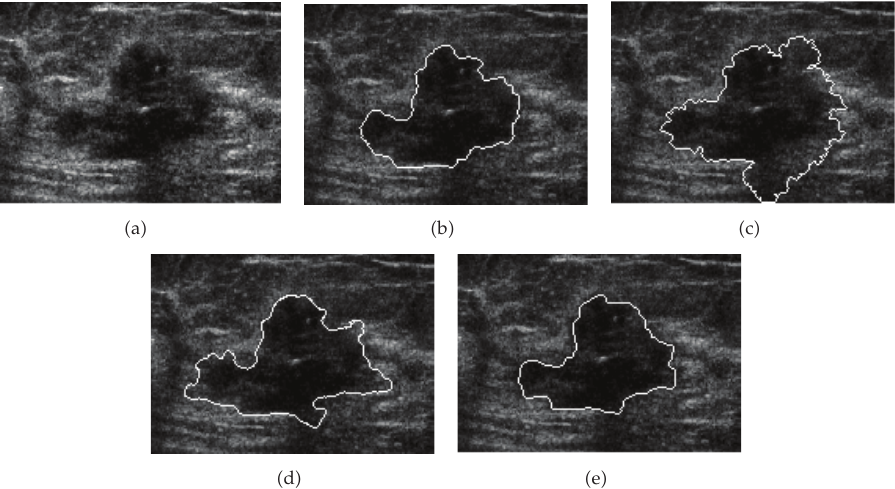
Figure 7: Segmentation of a malignant breast tumor having intensity inhomogeneity and weak boundaries. (cid:3) a (cid:4) Original image. (cid:3) b (cid:4) Golden standard. Segmentation results of (cid:3) c (cid:4) GAC (cid:5) 11 (cid:6) , (cid:3) d (cid:4) DRLSE (cid:5) 16 (cid:6) , and (cid:3) e (cid:4) the proposed PGBLSE